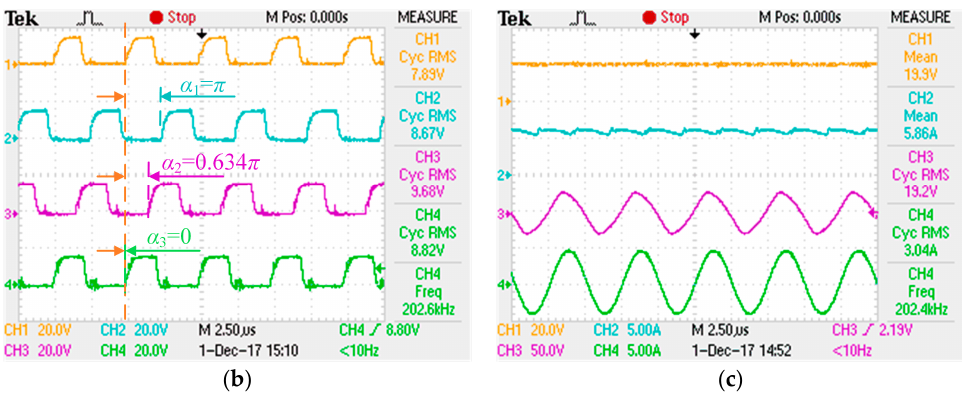
Figure 17. Practical measurements in the conditions Θ = 90°, Φ = 45°, θ ′ = 0°, φ ′ = 90°, ψ ′ = 0° and d = 0.4 m. ( a ) Locations and postures of system coils; ( b ) phase-shifted drive pulses; ( c ) input/output voltage and current waveforms.